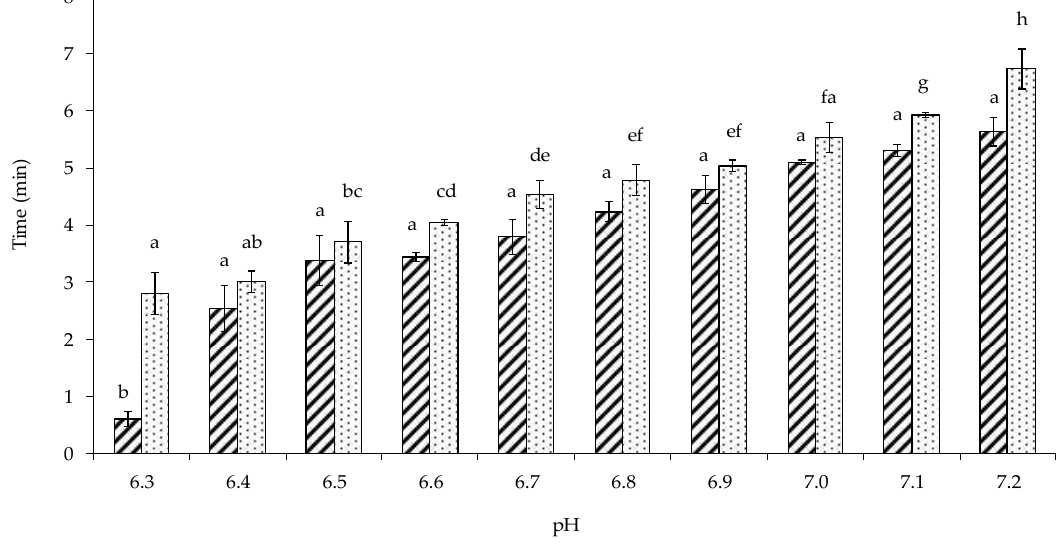
Figure 4. Influence of pH on the heat onset ( ) and coagulation ( ) time at 140 °C, pH 6.8, of control (i.e., no calcium added) lentil protein-stabilised emulsions. (a – h) The statistical analysis was performed between heat onset or coagulation time results at different pH’s; samples not sharing a common superscript differed significantly ( p < 0.05).